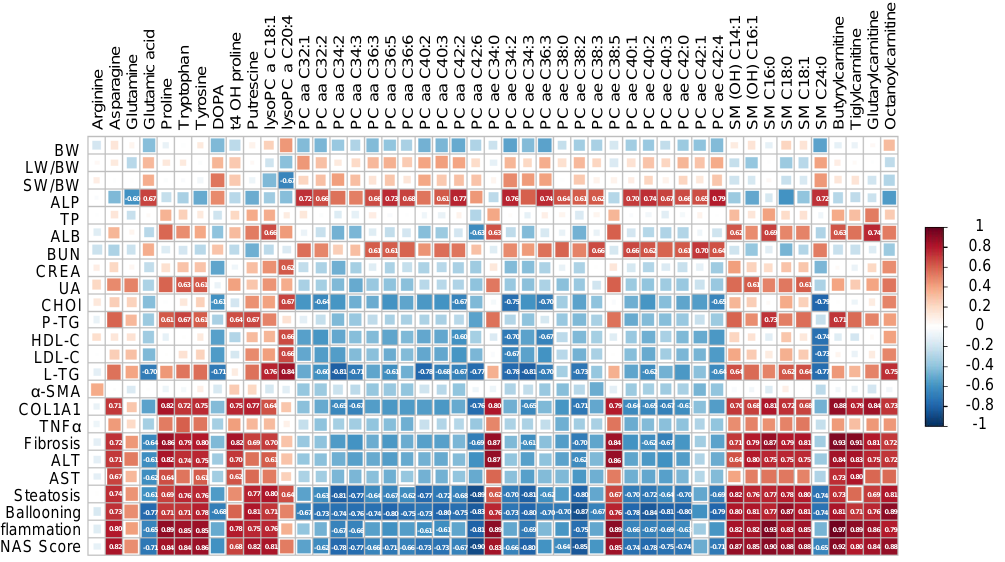
Figure 6. The correlations analysis between disease parameters and liver perturbed metabolites